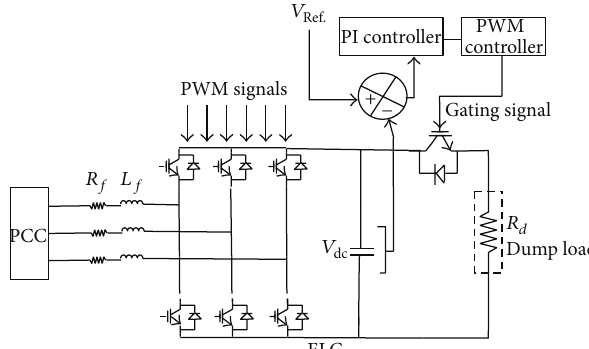
Figure 4: Schematic diagram of ELC and control scheme for chop- per.